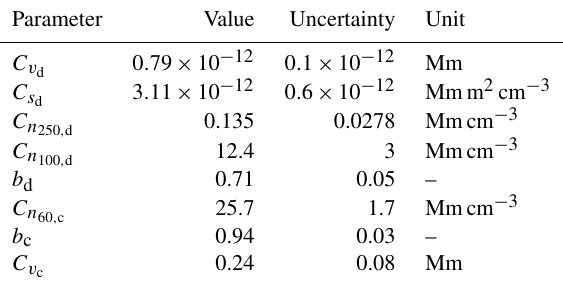
Table 2. Applied values of the conversion parameters required in the POLIPHON retrieval (Mamouri and Ansmann, 2016, 2017; Ans- mann et al., 2019b). The conversion factors are explained in the text and are needed to convert particle extinction coefficients into par- ticle mass concentrations and cloud-relevant parameters (CCN and INP concentrations). Indexes d and c denote dust and continental fine-mode aerosol pollution,